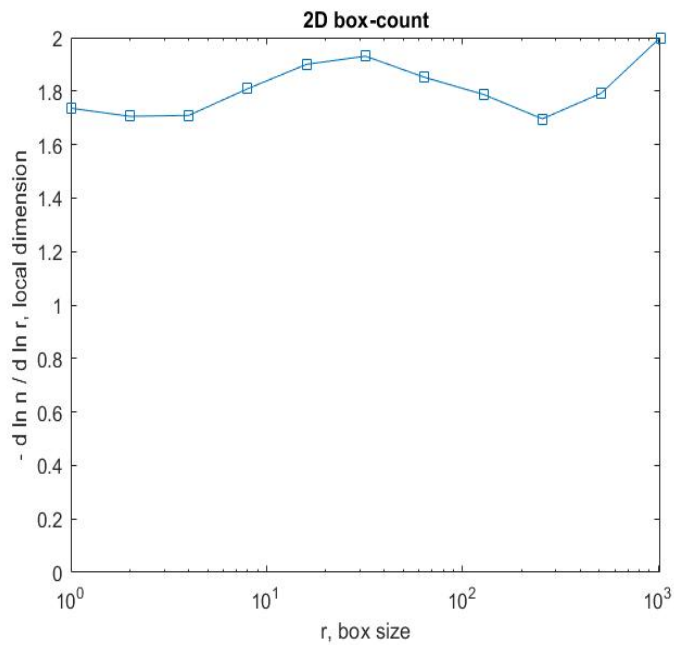
Figure 8. Two ‐ dimensional box ‐ count algorithm: fractal dimension. Figure 8. Two-dimensional box-count algorithm: fractal dimension.